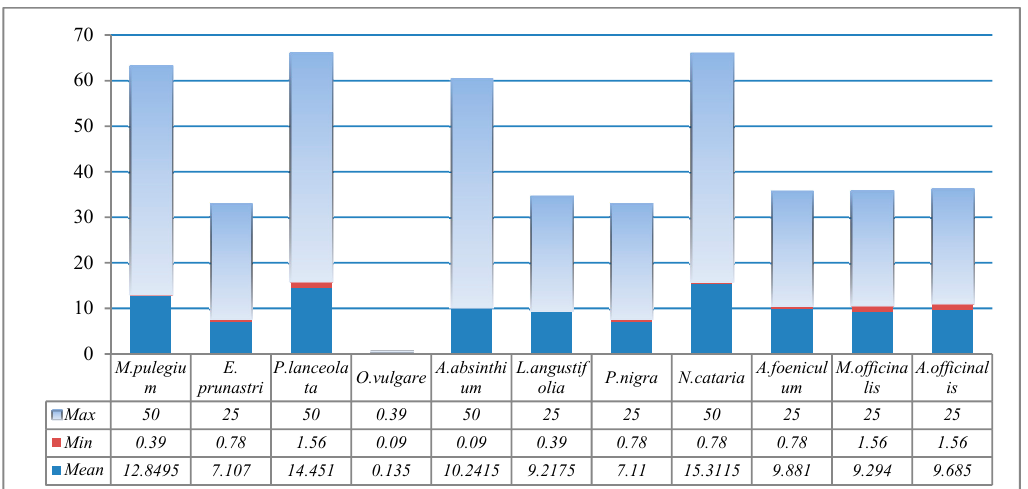
Figure 2. Minimum bactericidal concentration (MBC) values (mg/mL) for 11 plant extracts.